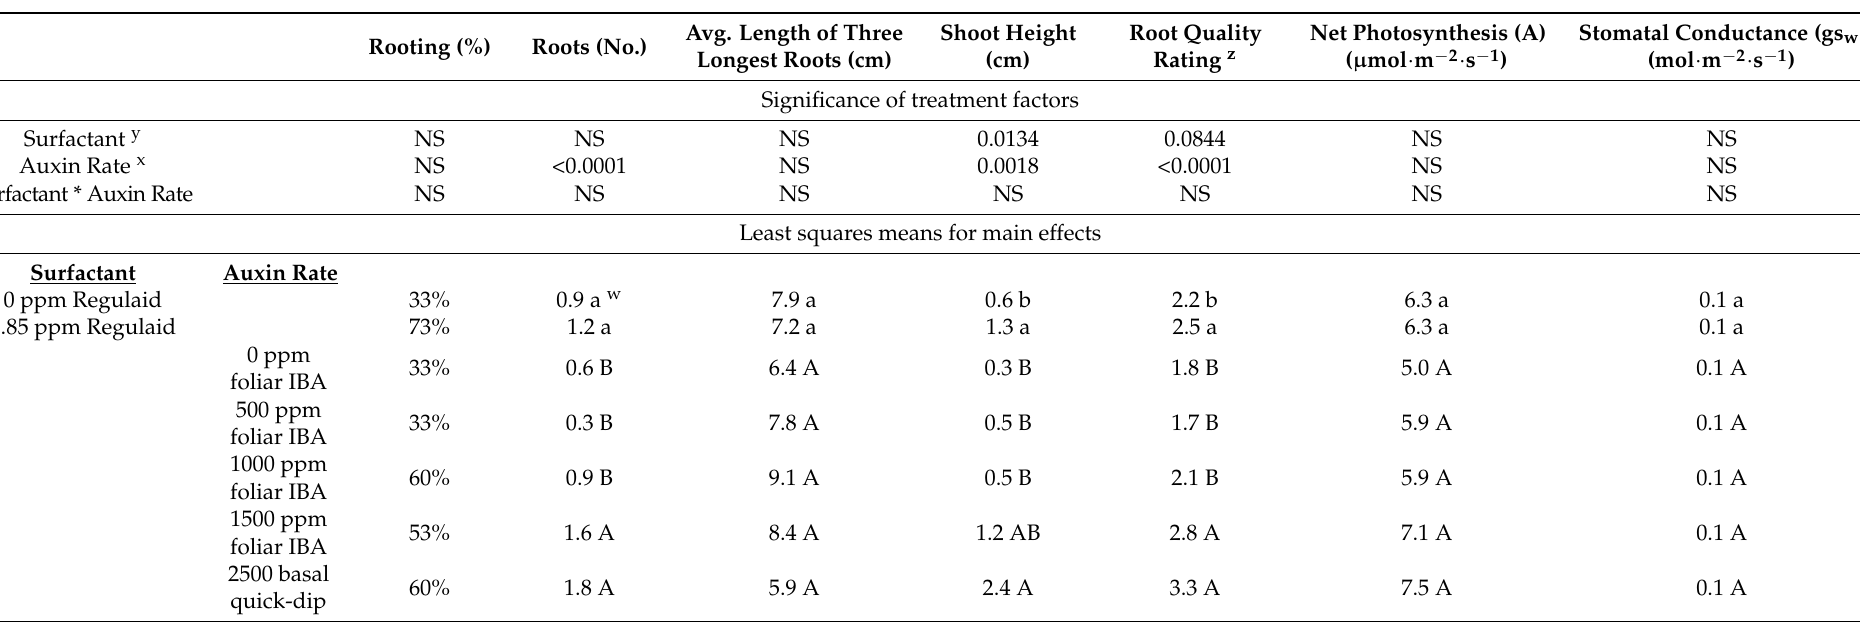
Table 3. Influence of surfactant and auxin rate on roots and shoots of ‘Southern Charm’ southern magnolia ( Magnolia grandiflora ‘Southern